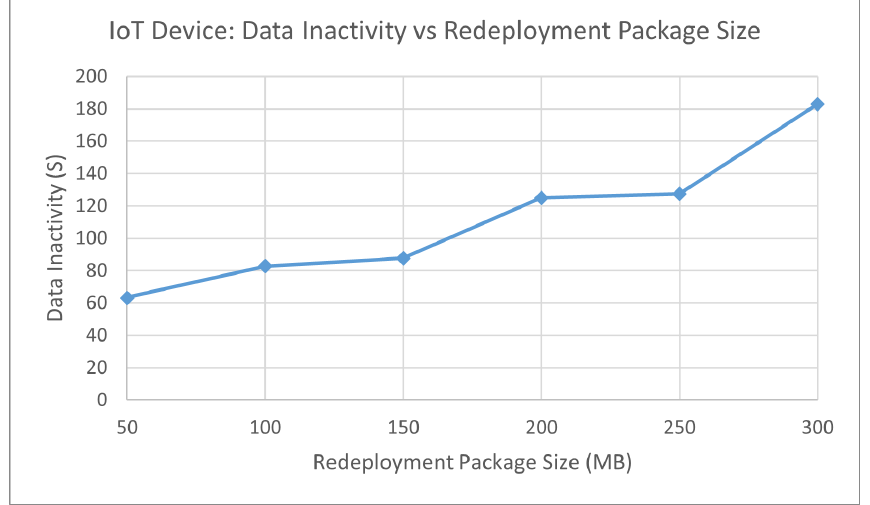
Figure 7. Data Inactivity vs. Redeployment Package